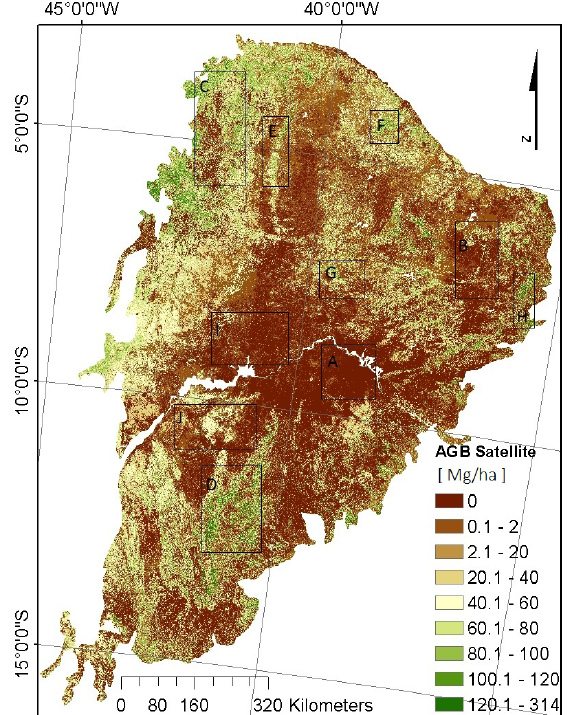
Figure 2. Estimated ground site above ground biomass (AGB) from phytosociological data from literature review across the Caatinga region (circles colored by AGB), light gray lines represent geomorphic limits. The insert boxes (from A to J) are for reference to specific regions highlighted in the supplementary material (Appendix S1). The full description of each field site and references, and estimates of AGB data and corresponding satellite data is presented in Table SI.